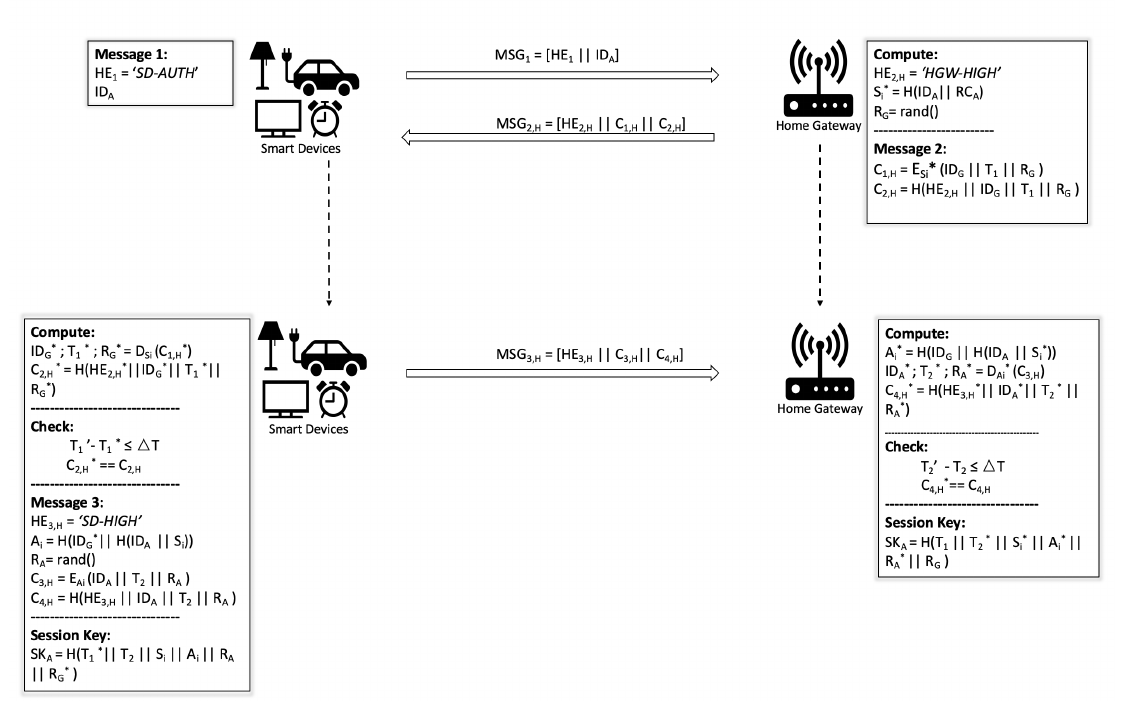
Figure 4. The message flow of the proposed scheme at high security risk ( P H